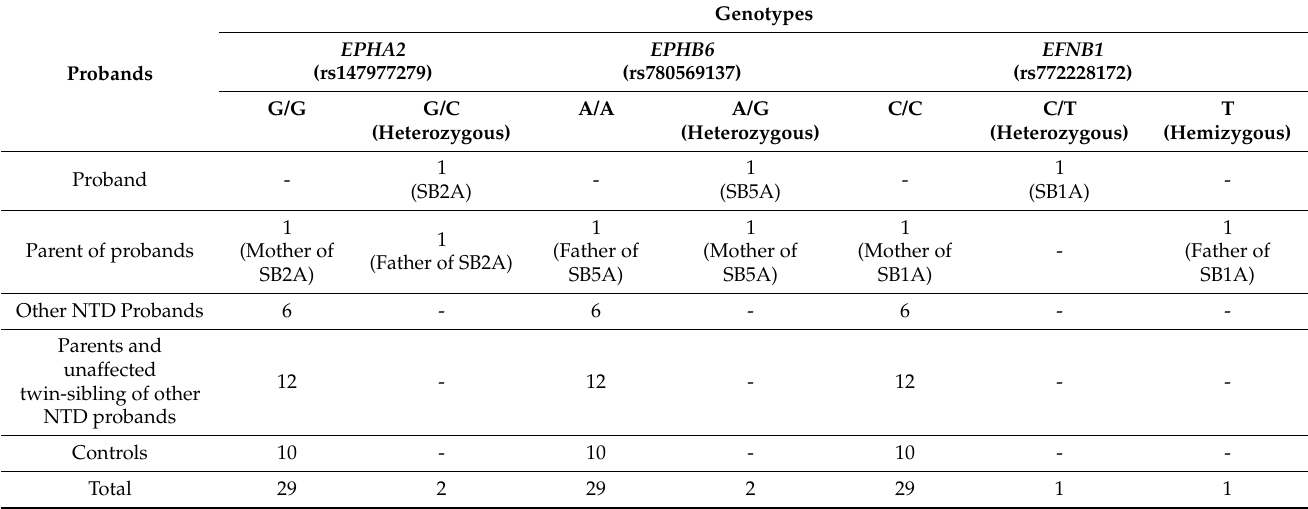
Table 1. Genotypes of spina bifida probands from exome datasets.